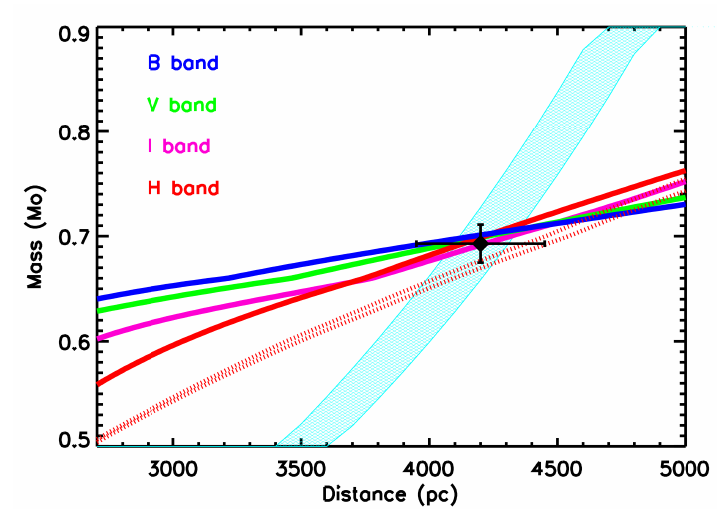
Figure 4. OGLE-2005-BLG-169 mass distance relations. The θ E mass-distance relation is the cyan curve. The B, V, I, and H measured lens flux-distance relations, based on empirical mass-distance relations [55,56] are plotted as blue, green, magenta, and red curves, respectively. Constraints from all passbands are in agreement and lead to M L = 0.69 ± 0.02 M (cid:12) orbited by a cold Neptune of 14.3 ± 0.7 M ⊕ . The system is at a distance D L = 4.2 ± 0.2 kpc. We also plotted the mass-distance relation using the H band measurement and 4–6.4 Gyr isochrones at solar metallicty [54]. If we would use this set of isochrones instead of the empircal one, we would obtain a mass ∼ 1 σ lower and a distance to the lens ∼ 0.5 σ shorter. It is required to clarify these small differences in the near future, for instance using a recalibrated empirical mass-luminosity relation using GAIA parallaxes.